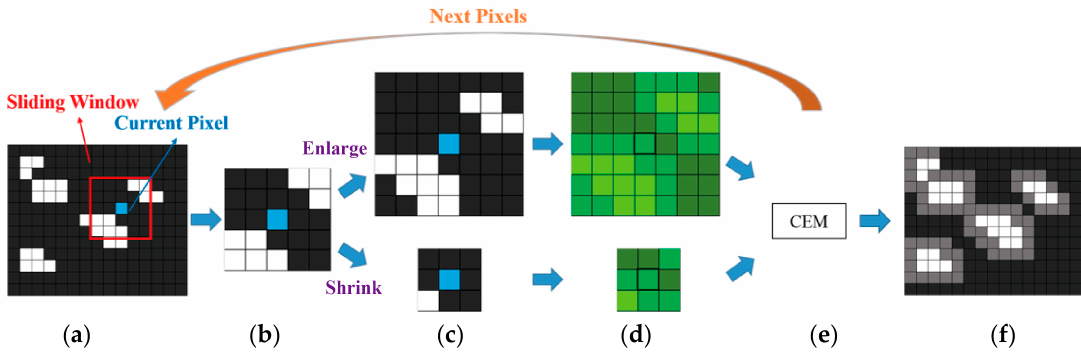
Figure 7. Flowchart of Adaptive Sliding Window CEM: ( a ) extract the newly grown leaves (NGL) around the current pixel from the preliminarily estimated sprout distribution map; ( b ) calculate the proportion of NGL in the sliding window; ( c ) enlarge or shrink the sliding window according to the proportion of NGL; ( d ) extract the pixel values from the window in relative position of the original image; ( e ) calculate the autocorrelation matrix for the pixel values in the window and substitute it in CEM for calculation; if all pixel values in the image are not finished, calculate the next pixel; and, ( f ) export the result of all pixel values.